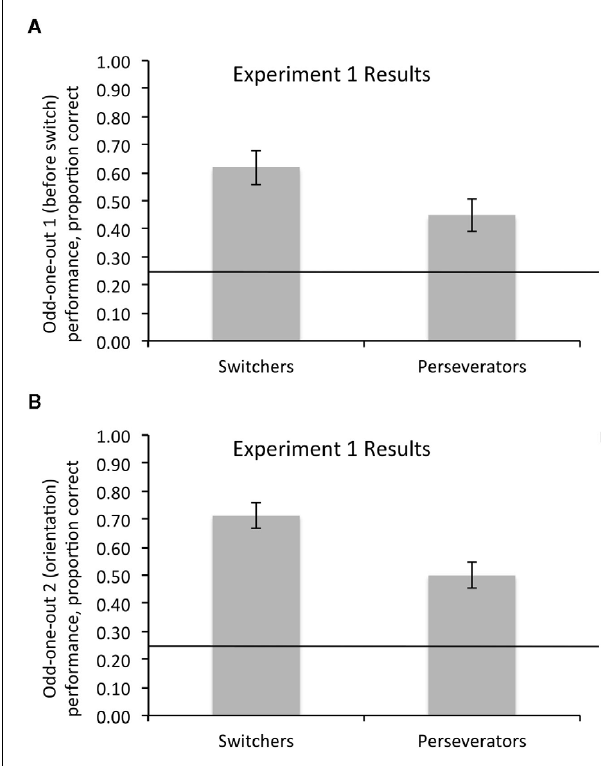
FIGURE 2 | Switchers performed better than perseverators at abstracting the relevant dimension on odd-one-out tasks, (A) before the switching task, and (B) requiring the abstraction of a dimension (orientation) not previously used in the switching task. Both groups performed better than chance ( p s < 0.006), indicated by the horizontal lines. Error bars represent SEM.